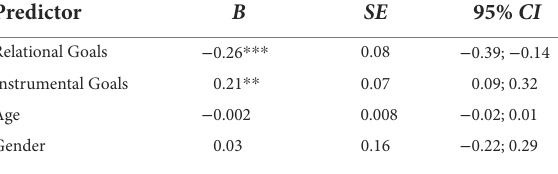
TABLE 2 Results on perceived appropriateness of a moral or competent candidate using latent variables (Study 1).